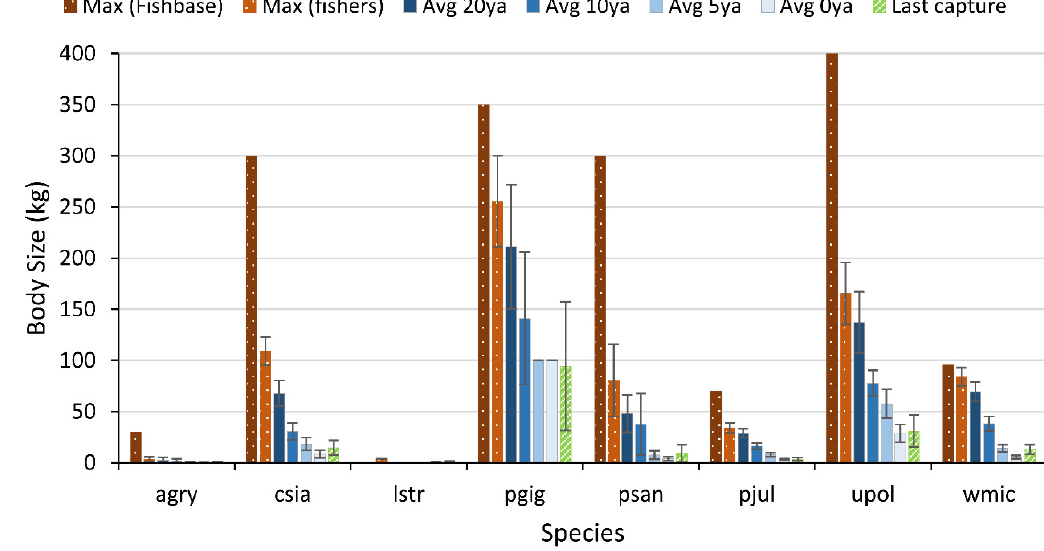
Figure 4. Temporal trends in Cambodian megafish body size (kg) with comparisons to maximum size and size of the last capture. Bars with orange-red shades and white speckling show the maximum reported size from FishBase (www.fishbase.org) and the maximum size known by fishers interviewed during local ecological knowledge surveys. The maximum size from FishBase for Urogymnus polylepis is 600 kg and is off the scale for graph clarity. Bars with solid blue shades show the average body size reported by fishers 20, 10, 5, and 0 years before the survey in June 2018 (“ya” = years ago). Green bars with white stripes show the body size of the most recent specimen captured by fishers. Each bar (except for the maximum size from FishBase) shows the mean and 95% confidence intervals calculated from fisher responses across the whole study area. Sample sizes for each species are the total numbers of high-quality interviews for the whole study area reported in Table 2. For species abbreviations, see